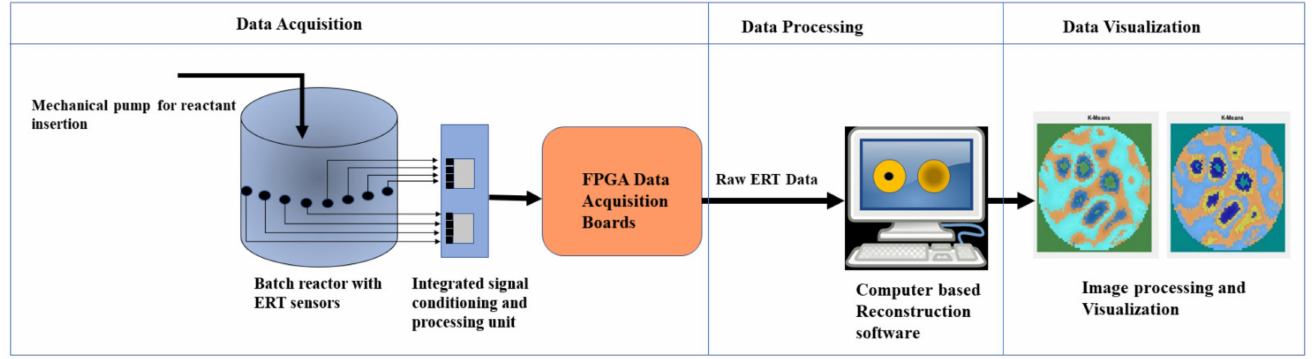
Figure 2. A schematic ERT system setup for reactive crystallization with data acquisition, data processing, and data visualization sections.